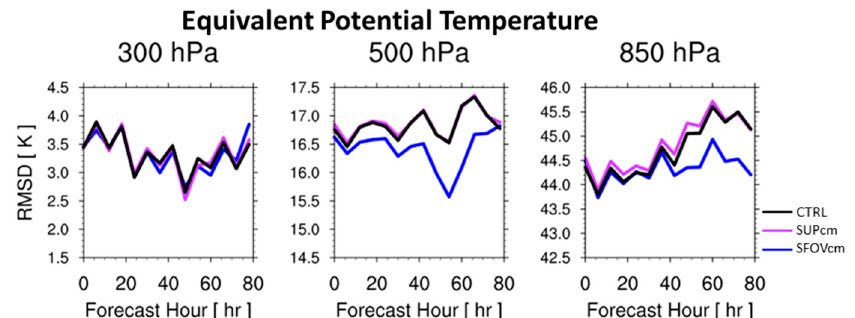
Figure 8. Statistics of the forecast performance of equivalent potential temperature at 300 ( left panel), 500 ( middle panel) and 850 ( right panel) hPa pressure levels for CTRL ( black curves), SUPcm ( purple curves) and SFOVcm ( blue curves) experiments.